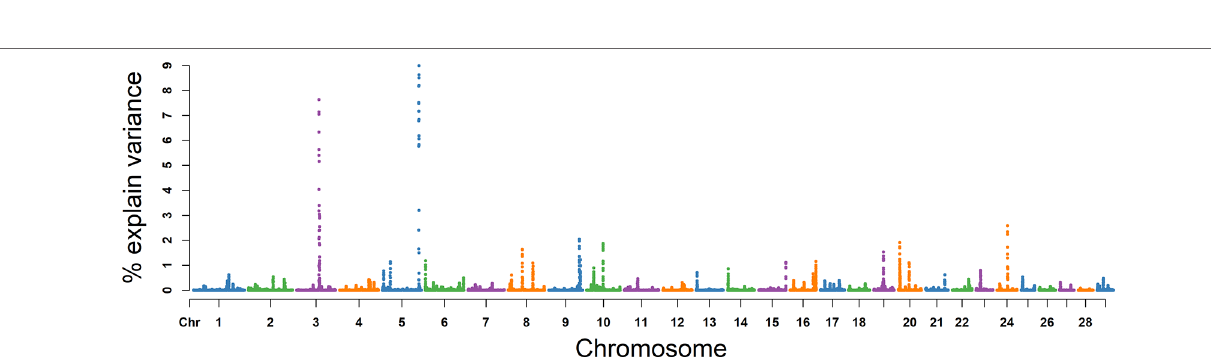
FIGURe 8 | GWAS results of number of sperms per ejaculate (NSP) in Holstein bulls of China. Each dot represents one SNP. The X-axis represents 29 autosomes, respectively. The Y-axis represents the percentage of the explained variance by SNP.